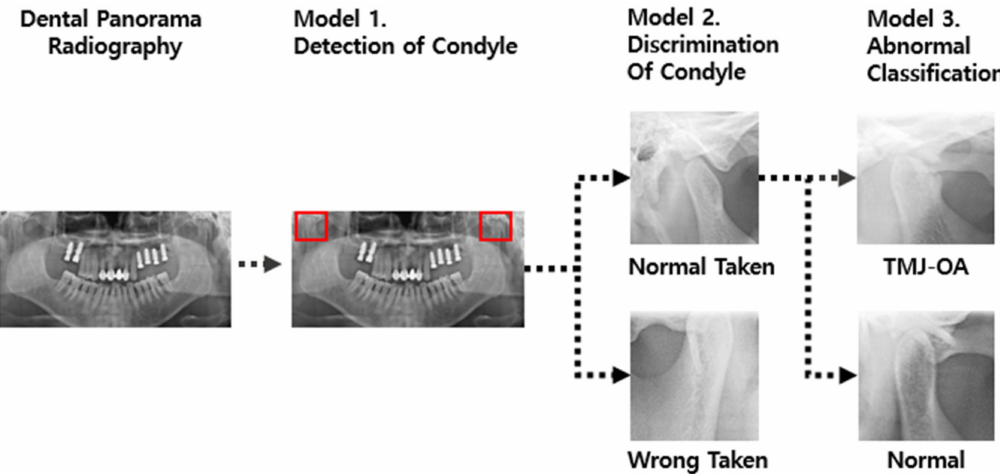
Figure 1. Architecture of the artificial intelligence (A)I classification algorithm of temporomandibular joint (TMJ) disease in dental panoramic radiography